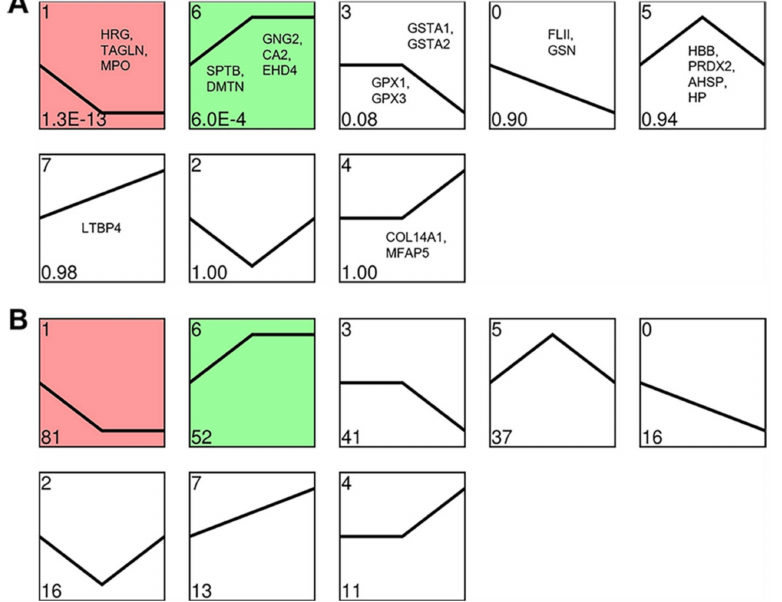
Figure 11. Cluster analysis of the expression patterns of DEPs in Tibetan sheep lungs with in- creasing altitude. Expression patterns are shown based on their p -value ( A ) and number ( B ) of DEPs in the lower left corner, colored patterns indicate significantly enriched patterns with altitude ( p < 0.05). The proteins in the patterns are the key DEPs enriched in the corresponding patterns. Histidine rich glycoprotein (HRG), Transgelin (TAGLN), Myeloperoxidase (MPO), Spectrin beta chain, erythrocytic (SPTB), Dematin (DMTN), Guanine nucleotide binding protein subunit gamma 2 (GNG2), Carbonic anhydrase 2 (CA2), EH domain containing protein 4 (EHD4), Glutathione S- transferase A1 (GSTA1), Glutathione S-transferase A2 (GSTA2), Glutathione peroxidase 1 (GPX1), Glutathione peroxidase 3 (GPX3), Flightless 1 (FLII), Gelsolin (GSN), Hemoglobin subunit beta (HBB), Peroxiredoxin 2 (PRDX2), Alpha hemoglobin stabilizing protein (AHSP), Haptoglobin (HP), Latent transforming growth factor beta binding protein 4 (LTBP4), Collagen alpha-1(XIV) chain (COL14A1), Microfibrillar associated protein 5